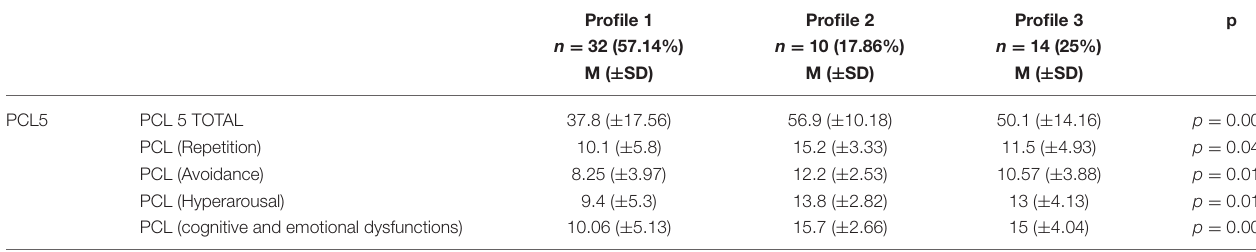
TABLE 3 | PCL5 scores in the pre-HRT session according to the three profiles.